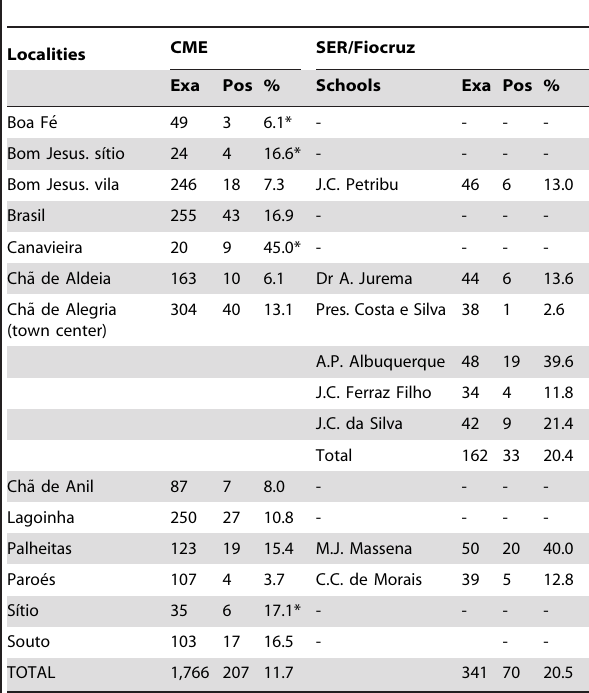
Table 3. Parasitological results from the population survey carried out by the Municipal Coordination of Endemic Diseases Diseases (CME) of Cha˜ de Alegria in 2003–2004 and from the school survey by the Schistosomiasis Reference Service of the Oswaldo Cruz Foundation (SRE/Fiocruz) one year later.